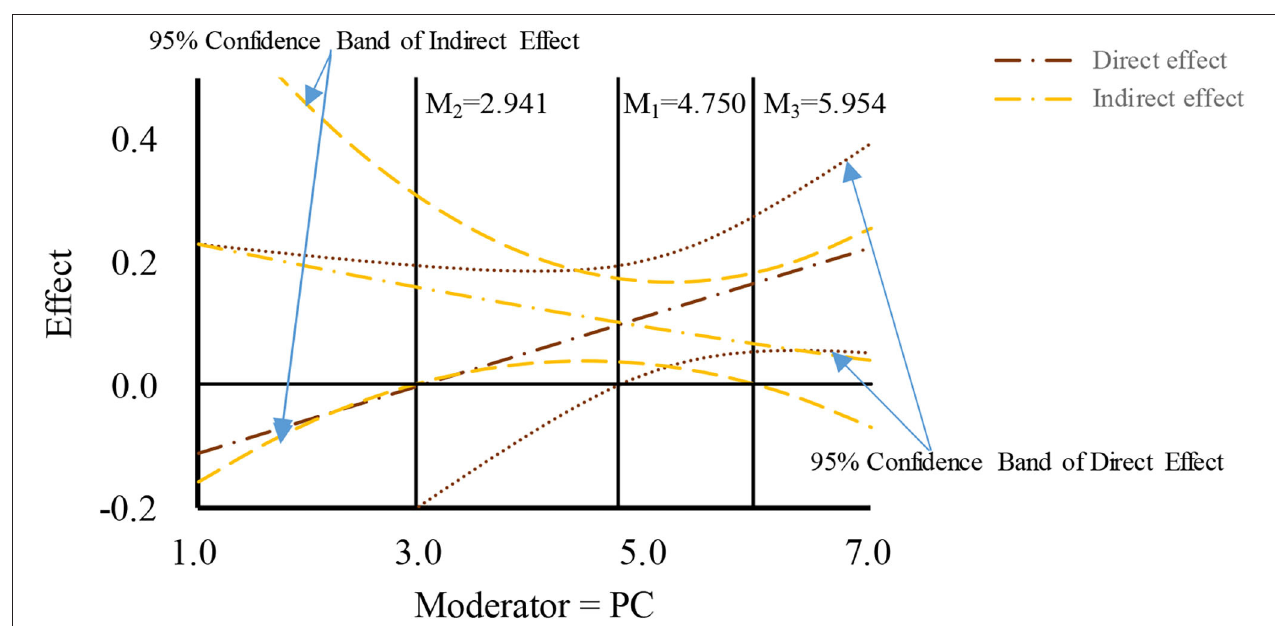
FIGURE 4 | Moderated mediation effect of product